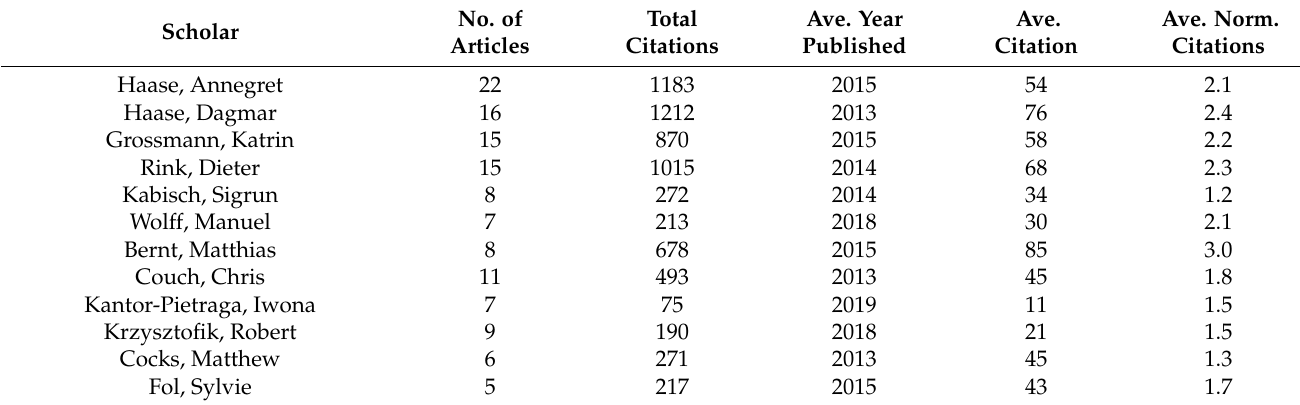
Figure 4. Co-authors analysis in SCT articles. Table 2. List of productive scholars in SCT-related